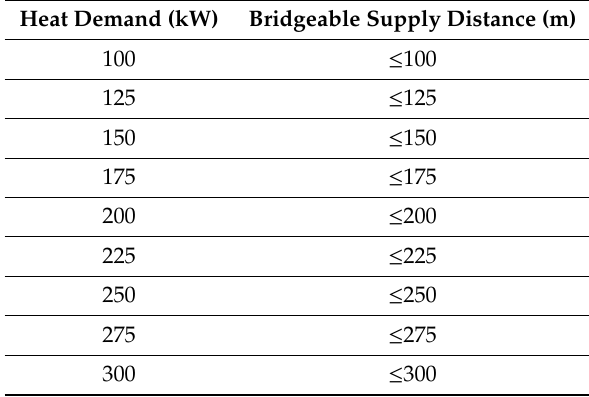
Table 1. Heat supply distances depending on supplied heat demand (own representation, based on